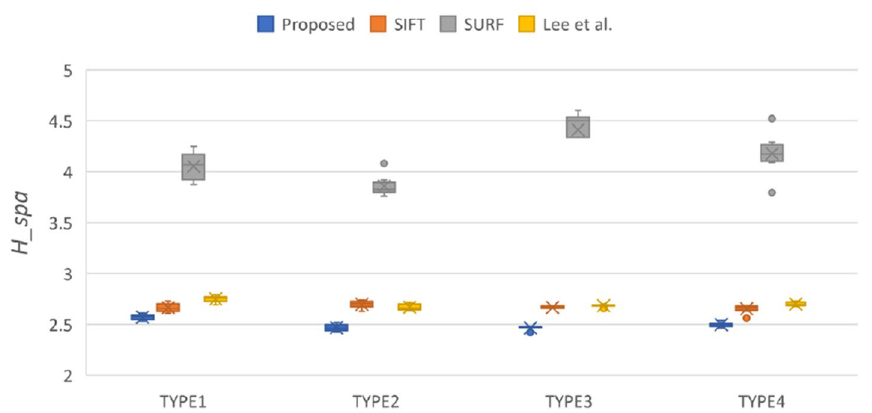
Figure 4. Compare the sparseness of detected feature points calculated by four methods in each